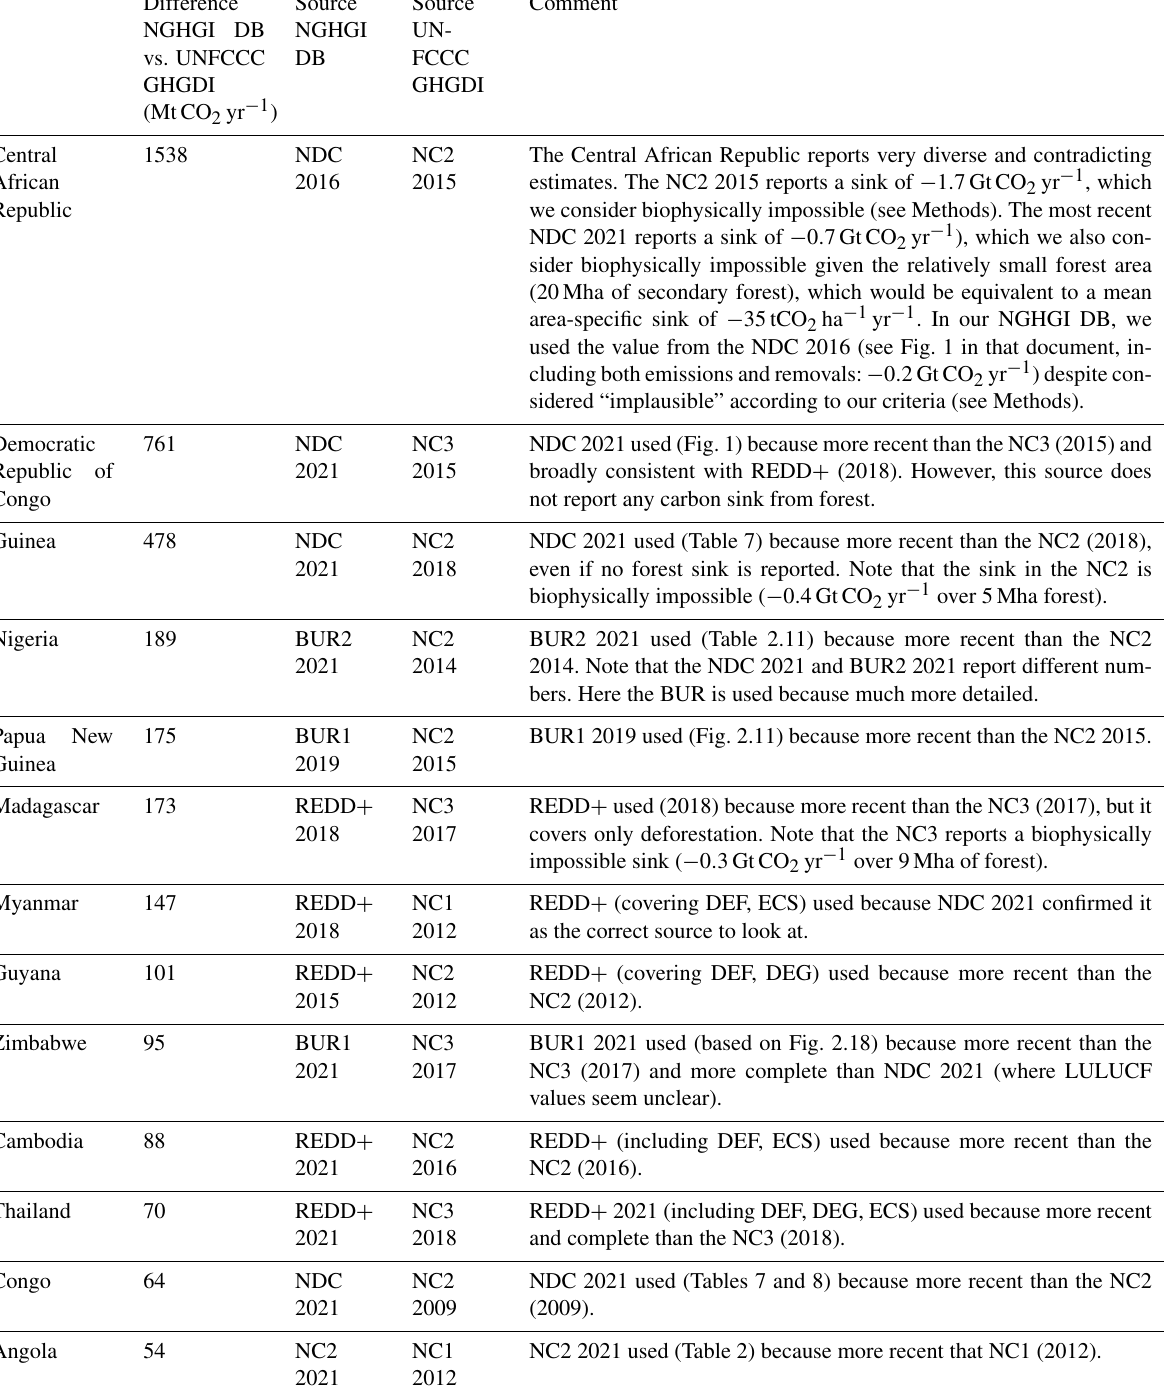
Table 7. Countries where the difference between the net LULUCF CO 2 flux in the NGHGI DB and in the UNFCCC GHGDI is greater than 50MtCO 2 yr − 1 (absolute values, i.e. positive numbers indicate greater emissions or smaller sinks in the NGHGI DB than the UNFCCC GHGDI), and explanation of the different source used. Collectively, these countries explain most of the difference in global LULUCF values between the two